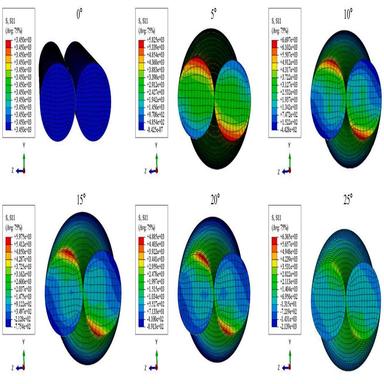
Stress distribution of carbon fiber tows with different twist angles for circular cross-section models.